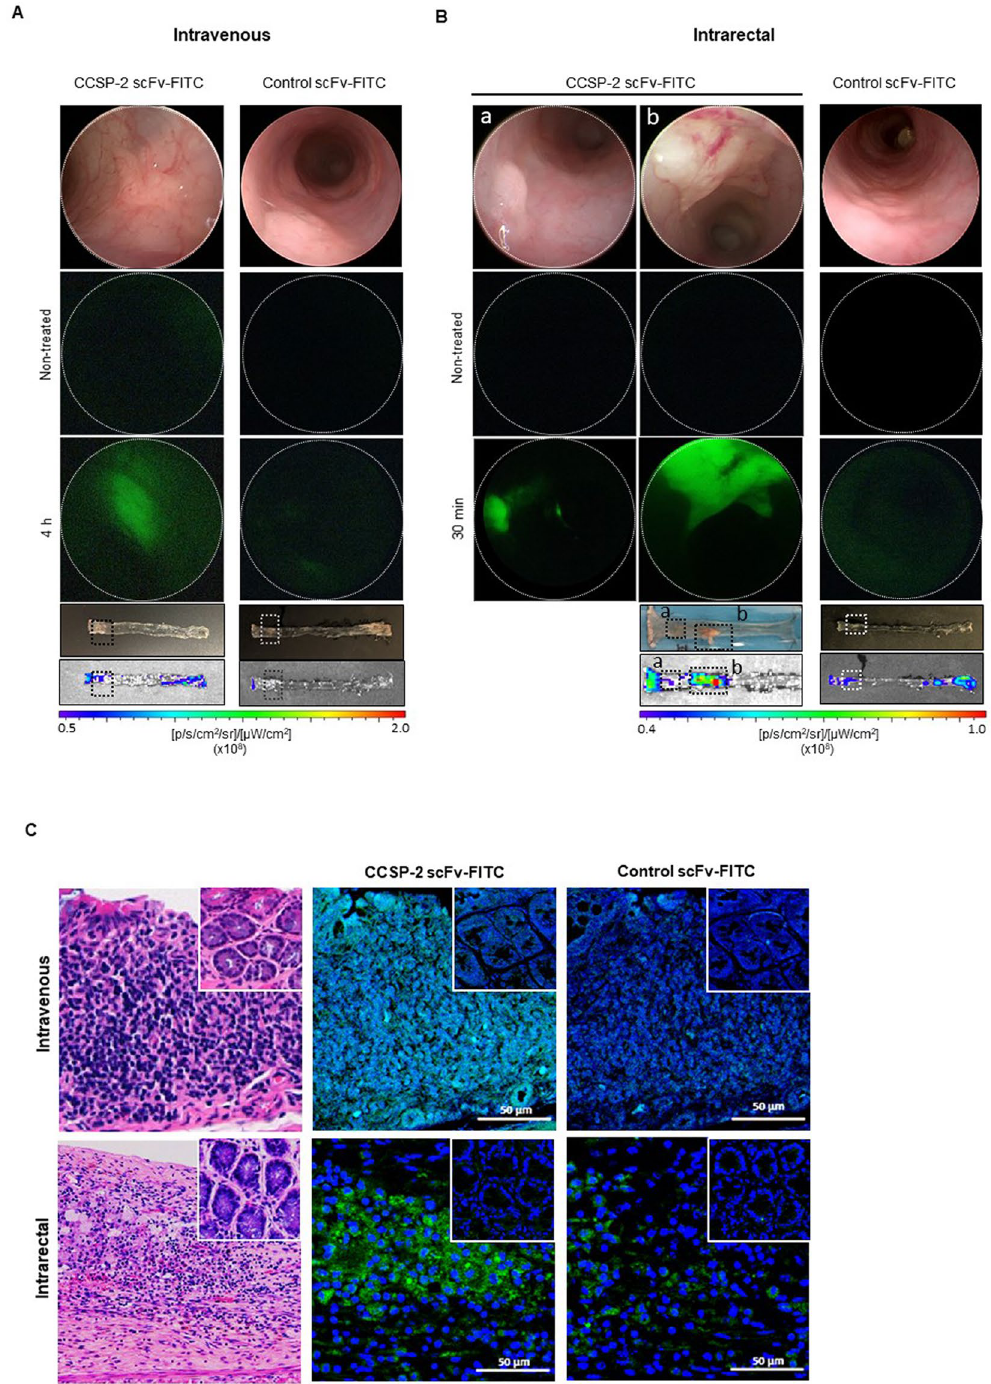
Figure 3. In vivo CCSP-2-targeted fluorescence colonoscopy in an orthotopic murine model. ( A ) Fluorescence images showing orthotopic cancer growth in a region with increased intensity with minimal background fluorescence in an anti-CCSP-2 scFv-FITC or control scFv-FITC-treated lesion compared with a non-treated lesion. The images were obtained 4 h after the i.v. injection of anti-CCSP-2 scFv-FITC or control scFv-FITC. Real-time white-light image of the tumor lesion was also acquired. ( B ) Fluorescence images showing distinct orthotopic cancer growth in a region with increased intensity in an anti-CCSP-2 scFv-FITC or control scFv- FITC-treated lesion compared with a non-treated lesion. The images were obtained 30 min after intrarectal administration of anti-CCSP-2 scFv-FITC or control scFv-FITC. Real-time white-light image of the tumor lesion was also acquired. ( C ) Histological analysis of tumor tissues from orthotopic xenograft mice injected with CCSP-2-overexpressing HCT116 cells. The inner square shows the adjacent normal